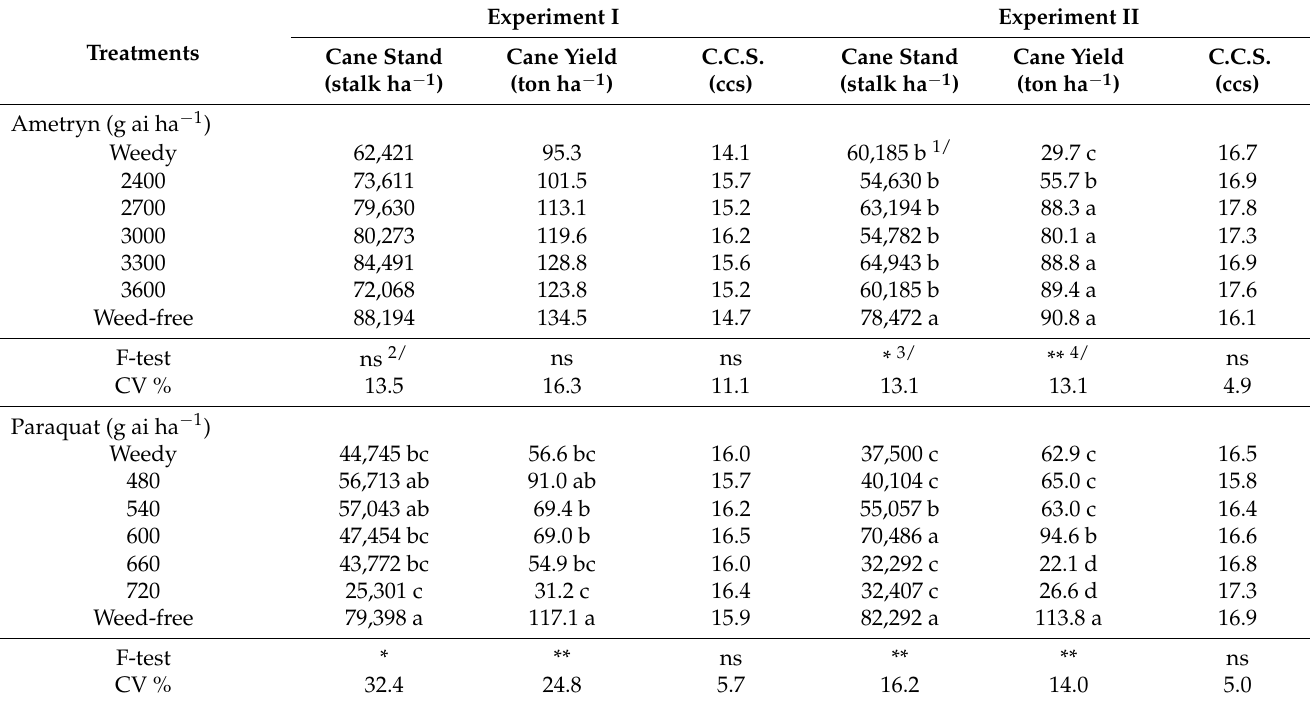
Table 5. Effects of ametryn and paraquat applications at various rates on yield and yield components of sugarcane in Experiments I and